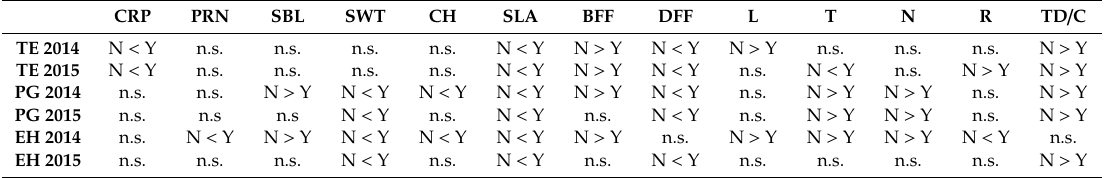
Table 2. Weed traits, Ellenberg ecological indicators, species richness and total density / cover of the weed communities in the two-years experiment as a ff ected by the ASC factor. CRP PRN SBL SWT CH N <